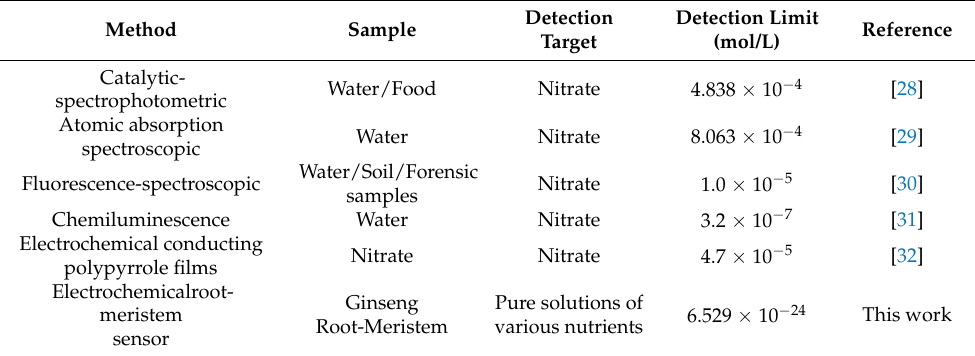
Table 2. Comparison of various detection methods available.